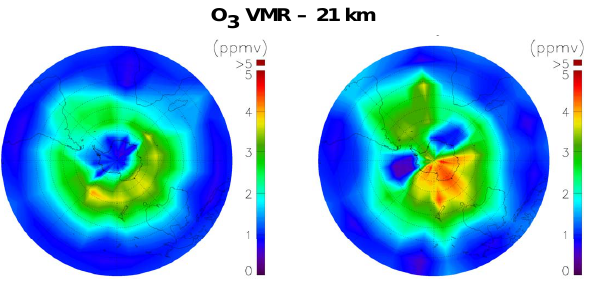
Fig. 17. Ozone VMR (ppmv) at 21km altitude in the South Pole region. The left panel shows the data measured on 13–16 September 2002, while the right panel shows the same region measured on 23–26 September 2002. The vortex split is clearly